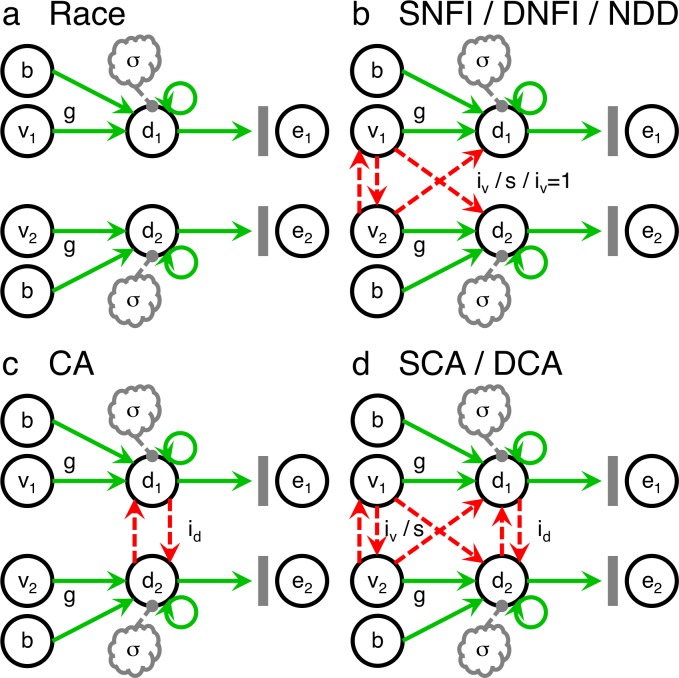
Dynamical models of neural decision making.(a) The race model [12–15] is the most basic of these by virtue of assuming that the representations of each option are completely independent. (b) Input-dependent competition is the signature feature common to the subtractive normalization-or-feedforward-inhibition (SNFI) model [34,35], the divisive normalization-or-feedforward-inhibition (DNFI) model [37–40], and the neural drift-diffusion (NDD) model [7,9–11]. The NDD model is nested within the SNFI model but instead posits perfect competition (i.e., iv = 1). (c) The competing-accumulator (CA) model [26,36] is instead characterized by state-dependent competition via lateral inhibition at the level of accumulating decision signals. (d) The subtractive competing-accumulator (SCA) and divisive competing-accumulator (DCA) models take a novel approach of including both input-dependent competition and state-dependent competition in tandem. Solid green and dashed red arrows indicate excitatory and inhibitory connections, respectively. At the level of value signals, the leftmost vertical and diagonal dashed red arrows denote lateral inhibition (i.e., input normalization or relative coding) and feedforward inhibition, respectively, which are represented collectively here because in this context they are equivalent in terms of output. The gray clouds reflect independent sources of noise. Vertical gray bars symbolize thresholding mechanisms. vx represents the ensemble of value-encoding neurons representing alternative x. dx represents the corresponding ensemble of decision-making neurons. ex represents the corresponding ensemble of execution neurons. The free parameters are b for baseline input, g for the gain of value-signal inputs, σ for noise, iv for value-signal inhibition as part of a subtractive transformation, s for semisaturation as part of a divisive transformation, and id for decision-signal inhibition.